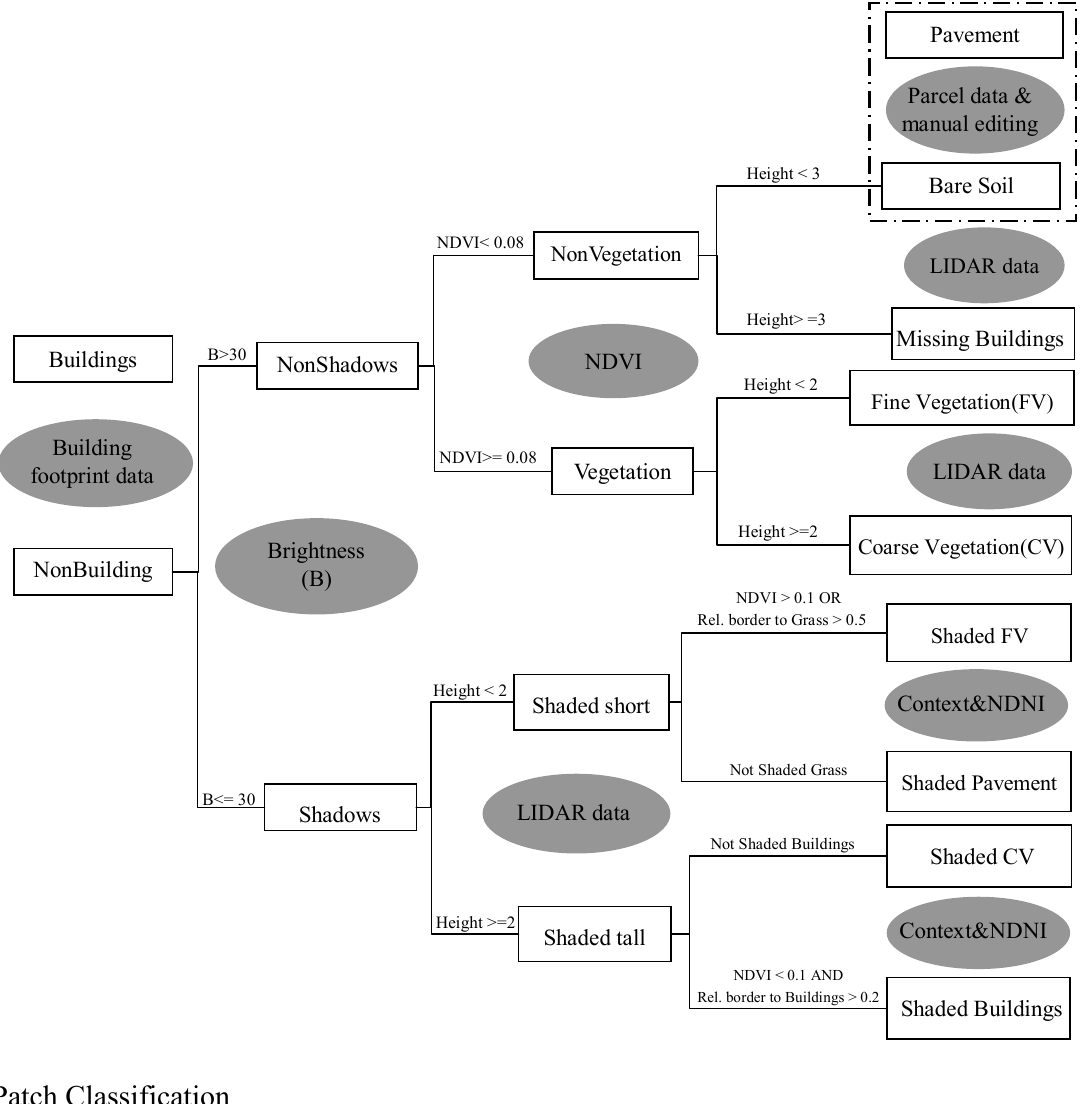
Figure 3. The class hierarchy, and its associated features and rules used for land cover classification (adapted from [4]). This classification hierarchy was used for the classifications of both image data collected in 1999 and 2004. Here the gray ovals refer to the features used for classification. Except for brightness, the values of the threshold for the features used for classification were identical for image data collected in 1999 and 2004. image